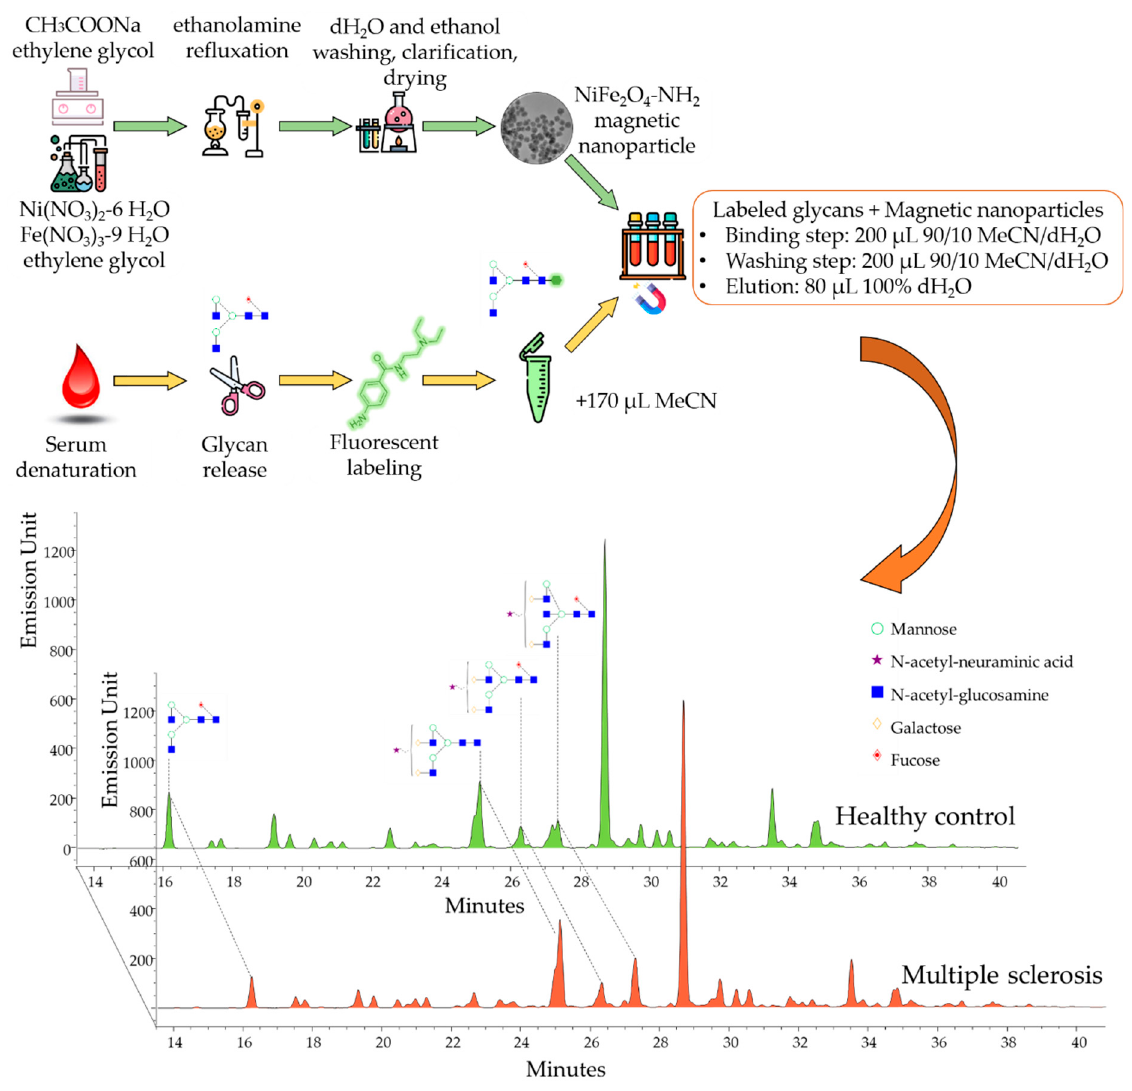
Figure 1. Scheme of the magnetic nanoparticle-based sample preparation for the N -glycomic analysis of patients with MS.